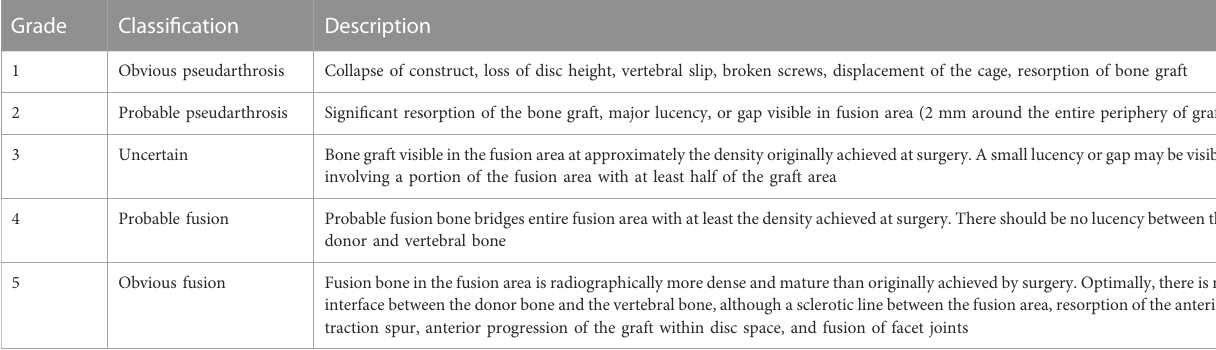
TABLE 1 Fusion result by Brantigan and Steffee (Lee et al., 2010b).